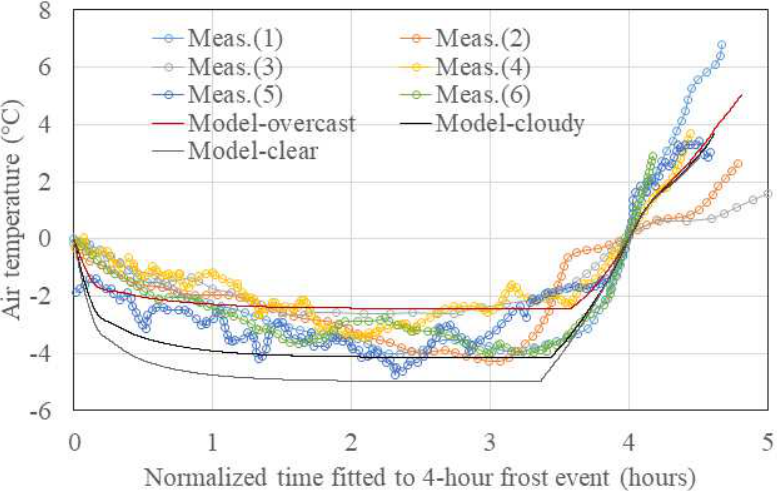
Figure 4. Comparison of air temperature simulation results of parametric CTFD model and field measurements from study